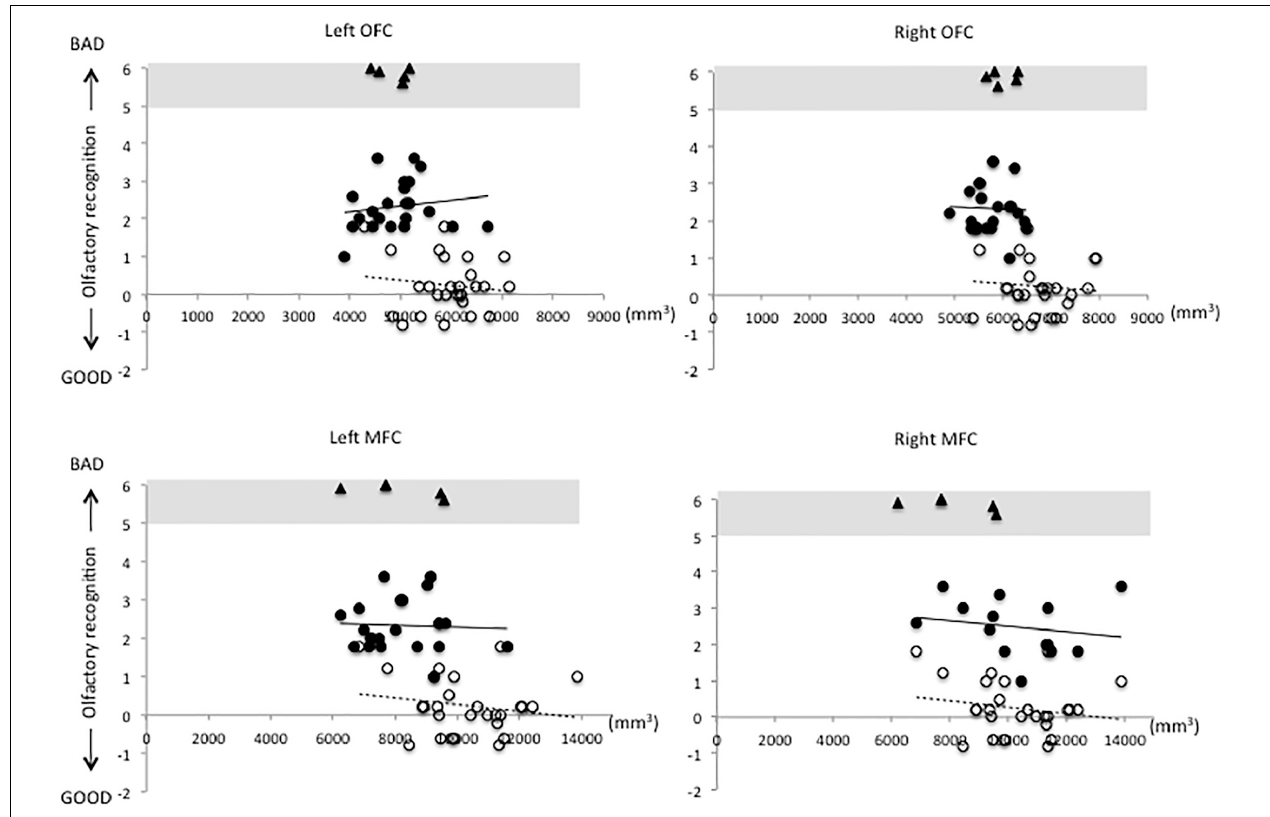
FIGURE 3 | Relationships between volumes of the olfactory cortex (OFC) and medial prefrontal cortex (MFC) and olfactory test scores in elderly and young subjects.